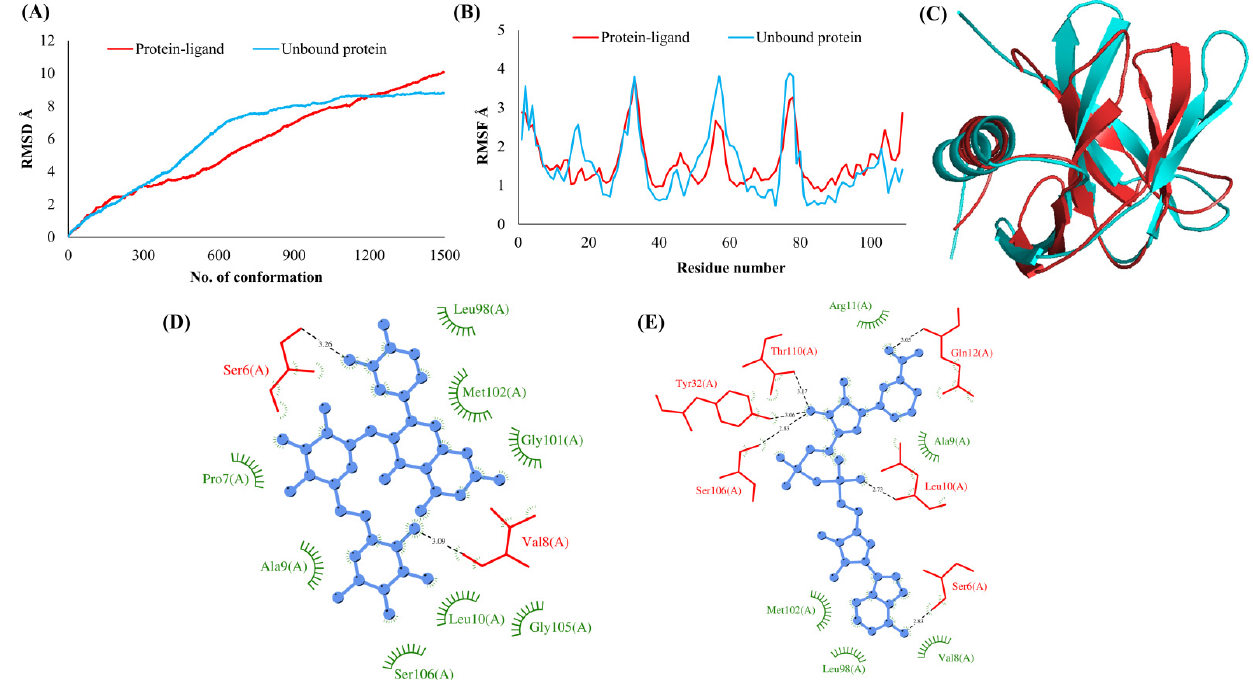
Figure 7. Endoribonuclease (NSP15). ( A ) RMSD plot of unbound and ligand-bound protein ( B ) RMSF plot of unbound and ligand-bound protein ( C ) Superimposition of unbound and ligand-bound protein ( D ) Molecular interactions of protein with Rutin ( E ) Molecular interactions of protein with NADH.